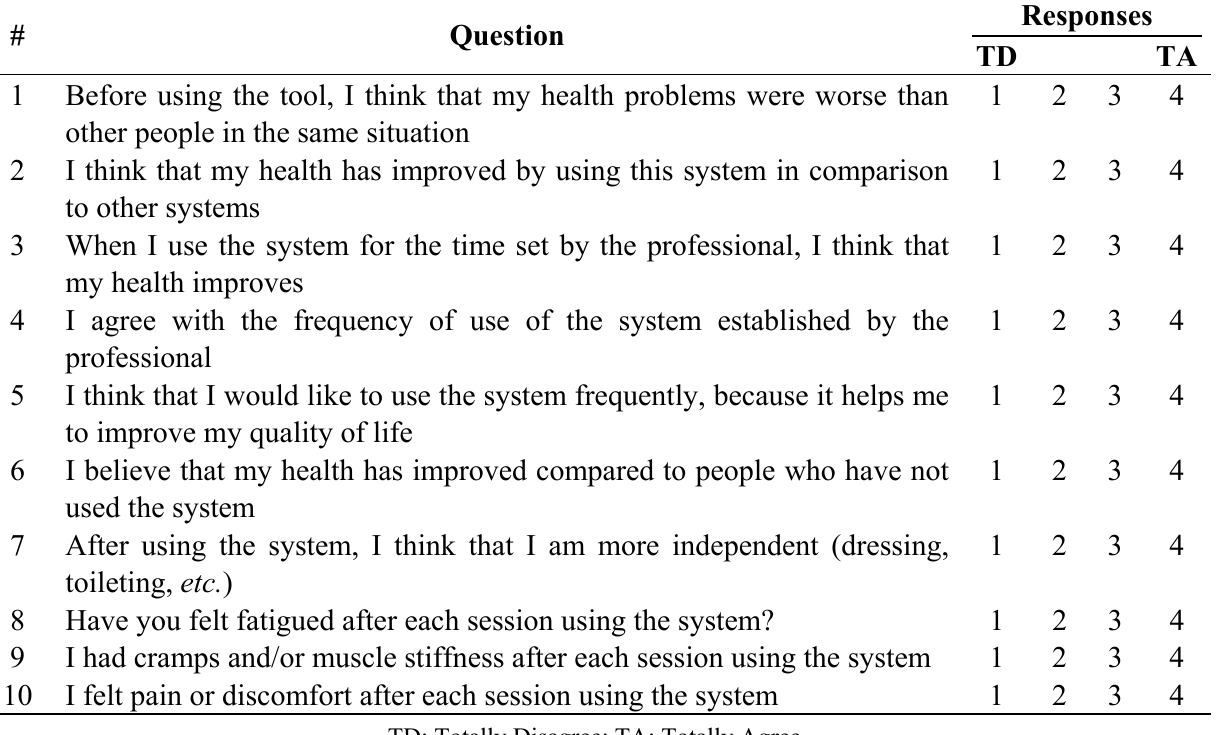
Table 3. Questionnaire no. 1: Benefits to patients.